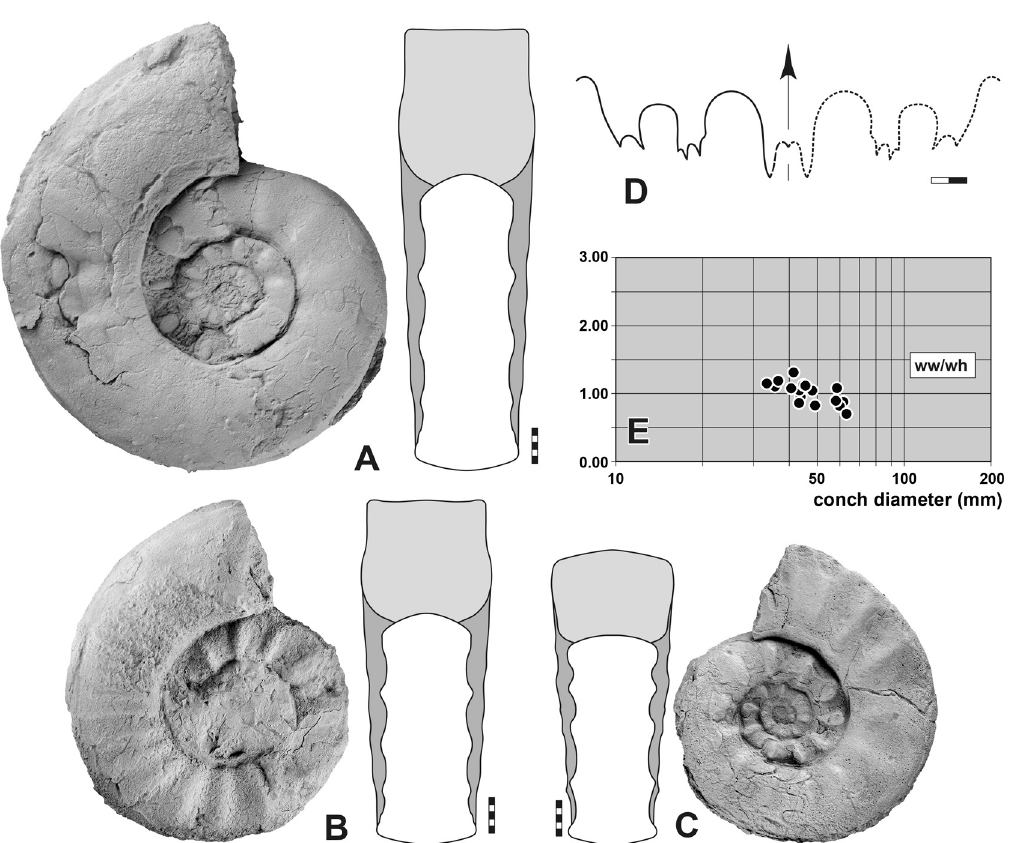
Fig. 57. Abichites alibashiensis Korn & Ghaderi, 2016. A . Lateral and dorsal view, specimen MB.C.30051, section E, float. B . Lateral and dorsal view, specimen MB.C.30046, section C, -0.50 m. C . Lateral and dorsal view, specimen MB.C.30045, section B, float. D . Suture line, specimen MB.C.30046, at 10.1 mm wh. E . Whorl profile proportions. Abbreviation: see Material and methods. Scale bar units = 1